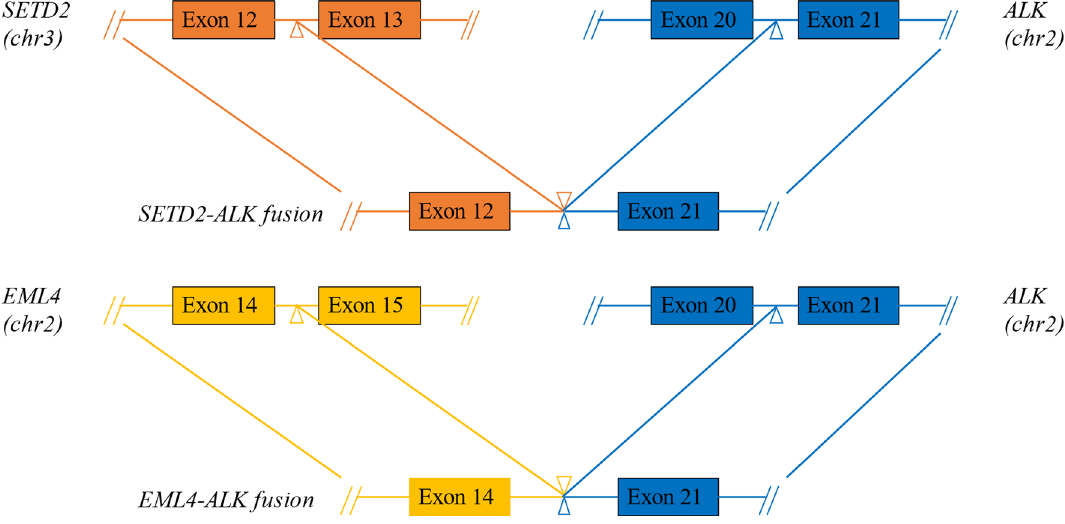
Fig. 1 Simulated picture of EML4-ALK and SETD2-ALK